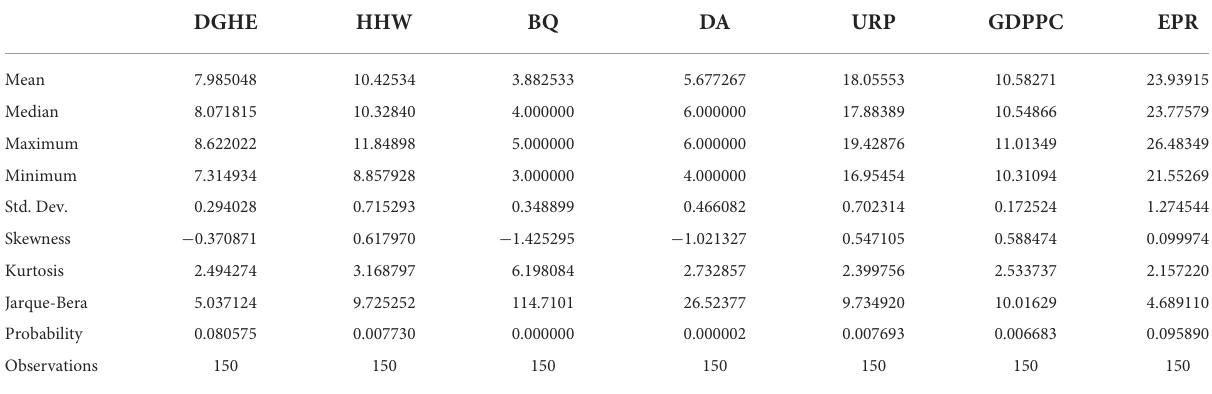
TABLE 1 Descriptive statistics and normality check.